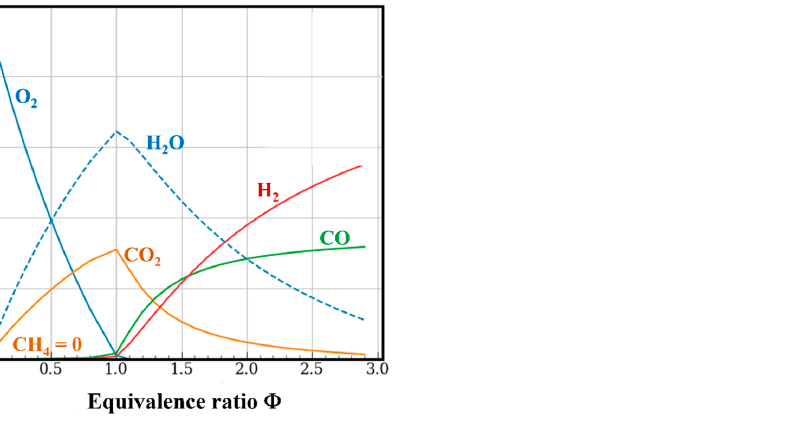
Figure 10. Calculated compositions of detonation products of CH 4 /O 2 mixtures with different values of Φ at the composition freezing temperature 2200 K ( f = 1 Hz, P = 0.1